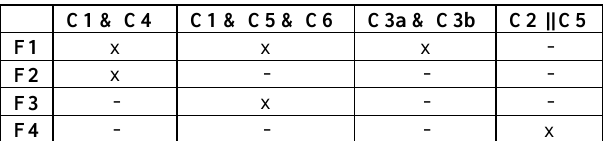
Table 3. Class Distribution over the land cover